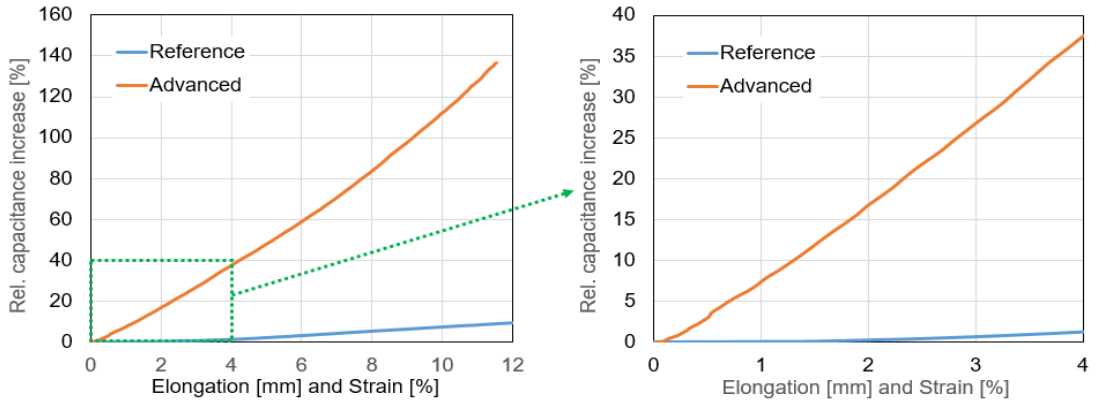
Figure 12. Comparison of the relative capacitance increase in the advanced strain sensor upon strain with that of the conventional strain sensor as reference [101].